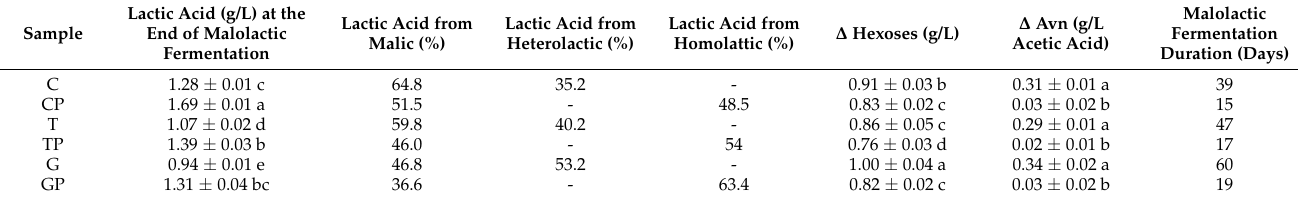
Table 6. Lactic acid at the end of malolactic fermentation, lactic acid from malic, lactic acid from heterolactic, lactic acid from homolattic, ∆ hexoses (difference between initial and final hexoses), ∆ AVN, and Malolactic fermentation duration (days). C = Castellina, G = Gaiole, T = Tavarnelle, CP = Castellina plantarum, GP = Gaiole plantarum, and TP = Tavarnelle